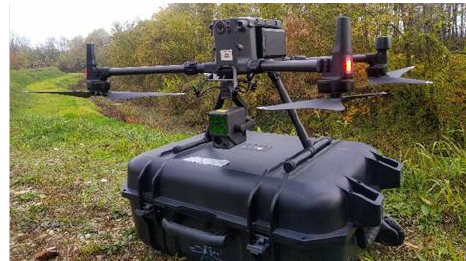
Figure 1. DJI Matrice 300 and DJI Zenmuse P1 camera.